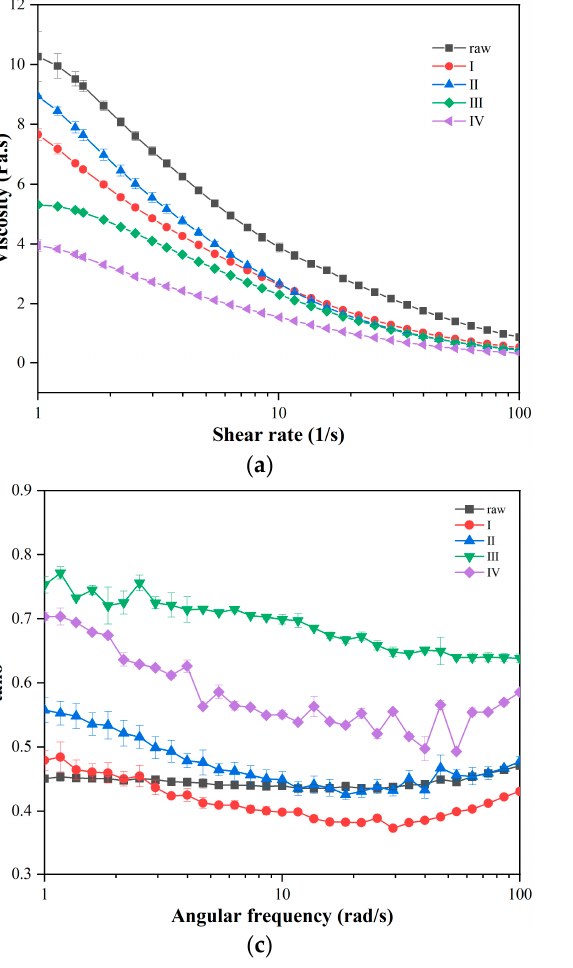
Figure 5. Rheological behavior of oat pasta at 90% moisture: variation of flow behavior with shear rate ( a ), variation of storage modules G’, loss modules G ″ ( b ) and tan δ ( c ) with frequency, and large amplitude oscillatory shear behavior ( d ) of native oats (raw), in mixing zone (I), cooking zone (II), melting zone (III), and extrudates